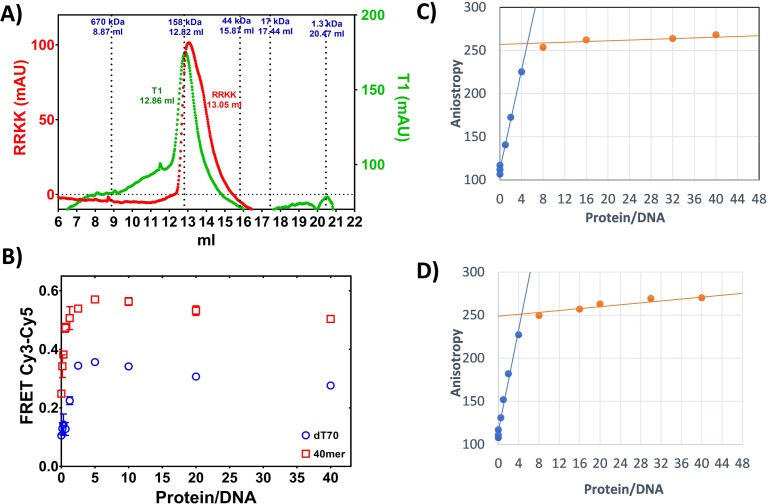
Oligomerization and DNA-binding stoichiometry of PALB2 N-DBD.(A) Gel filtration of the N-DBD (blue isotherm) and the 146AAAA mutant (red) using Superdex-200 10/300 column. Positions of BioRad MW standards with MW in kDa are shown on top. The elution volume of N-DBD correspond to tetrameric or pentameric structure. (B) FRET values of Cy3-ss40-Cy5 (red) and Cy3-dT70-Cy5 (blue) oligonucleotides upon titration by N-DBD. (C) and D) Titration of FAM-labelled ss49 at 50 nM in (C) and 100 nM in (D) by N-DBD.